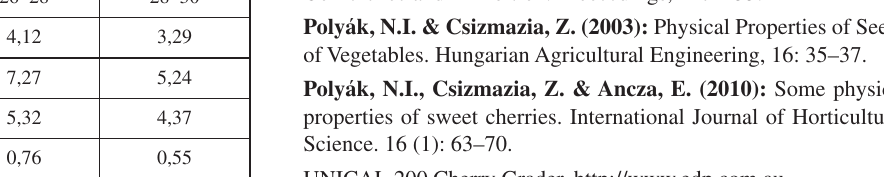
Table 6. The average values for the stone-pulp ratio (%) Canada Giant